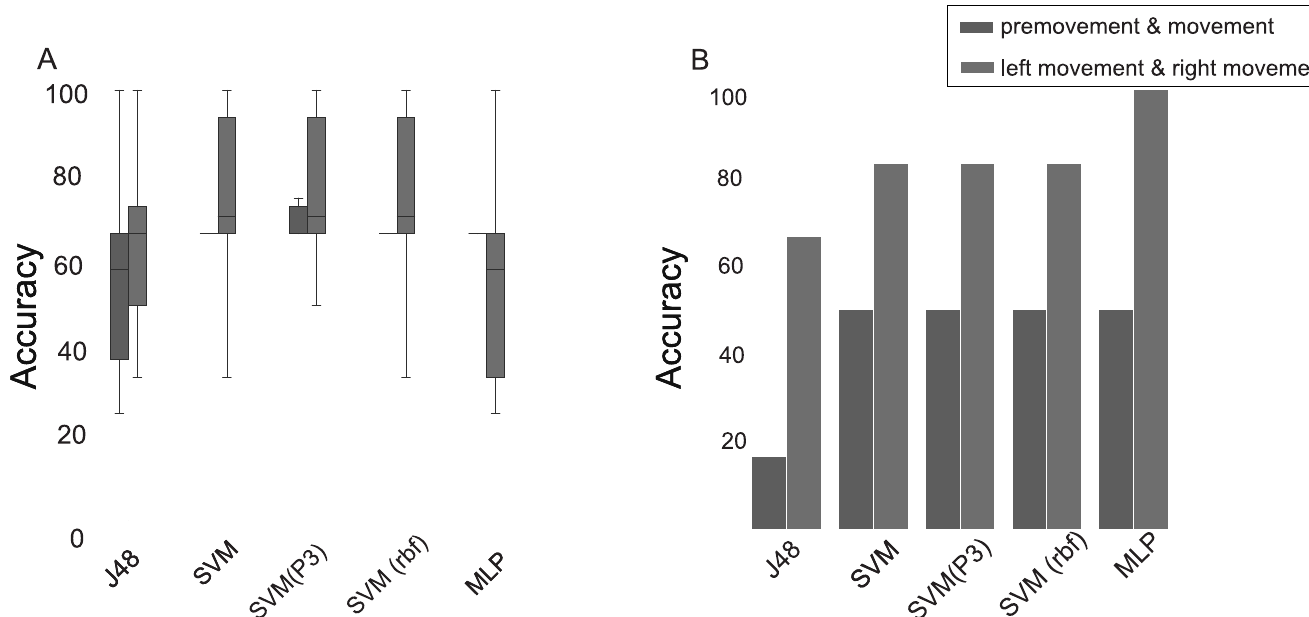
Fig 6. Machine learning-based model performance. (A) Training accuracies for central regions on using SVM had outperformed MLP and DT for left and right hand movement (SVM: Support Vector machine; SVM-(P3): support vector machine polynomial degree 3, SVM (rbf): Support vector machine—radial basis function, MLP: Multilayer Perceptron) (B) Testing accuracy performance with central regions SVMs has performed similarly with 50% accuracy for premovement & movement, and 80% accuracy for left and right hand movement classification DT has performed moderately for left vs right hand movement.